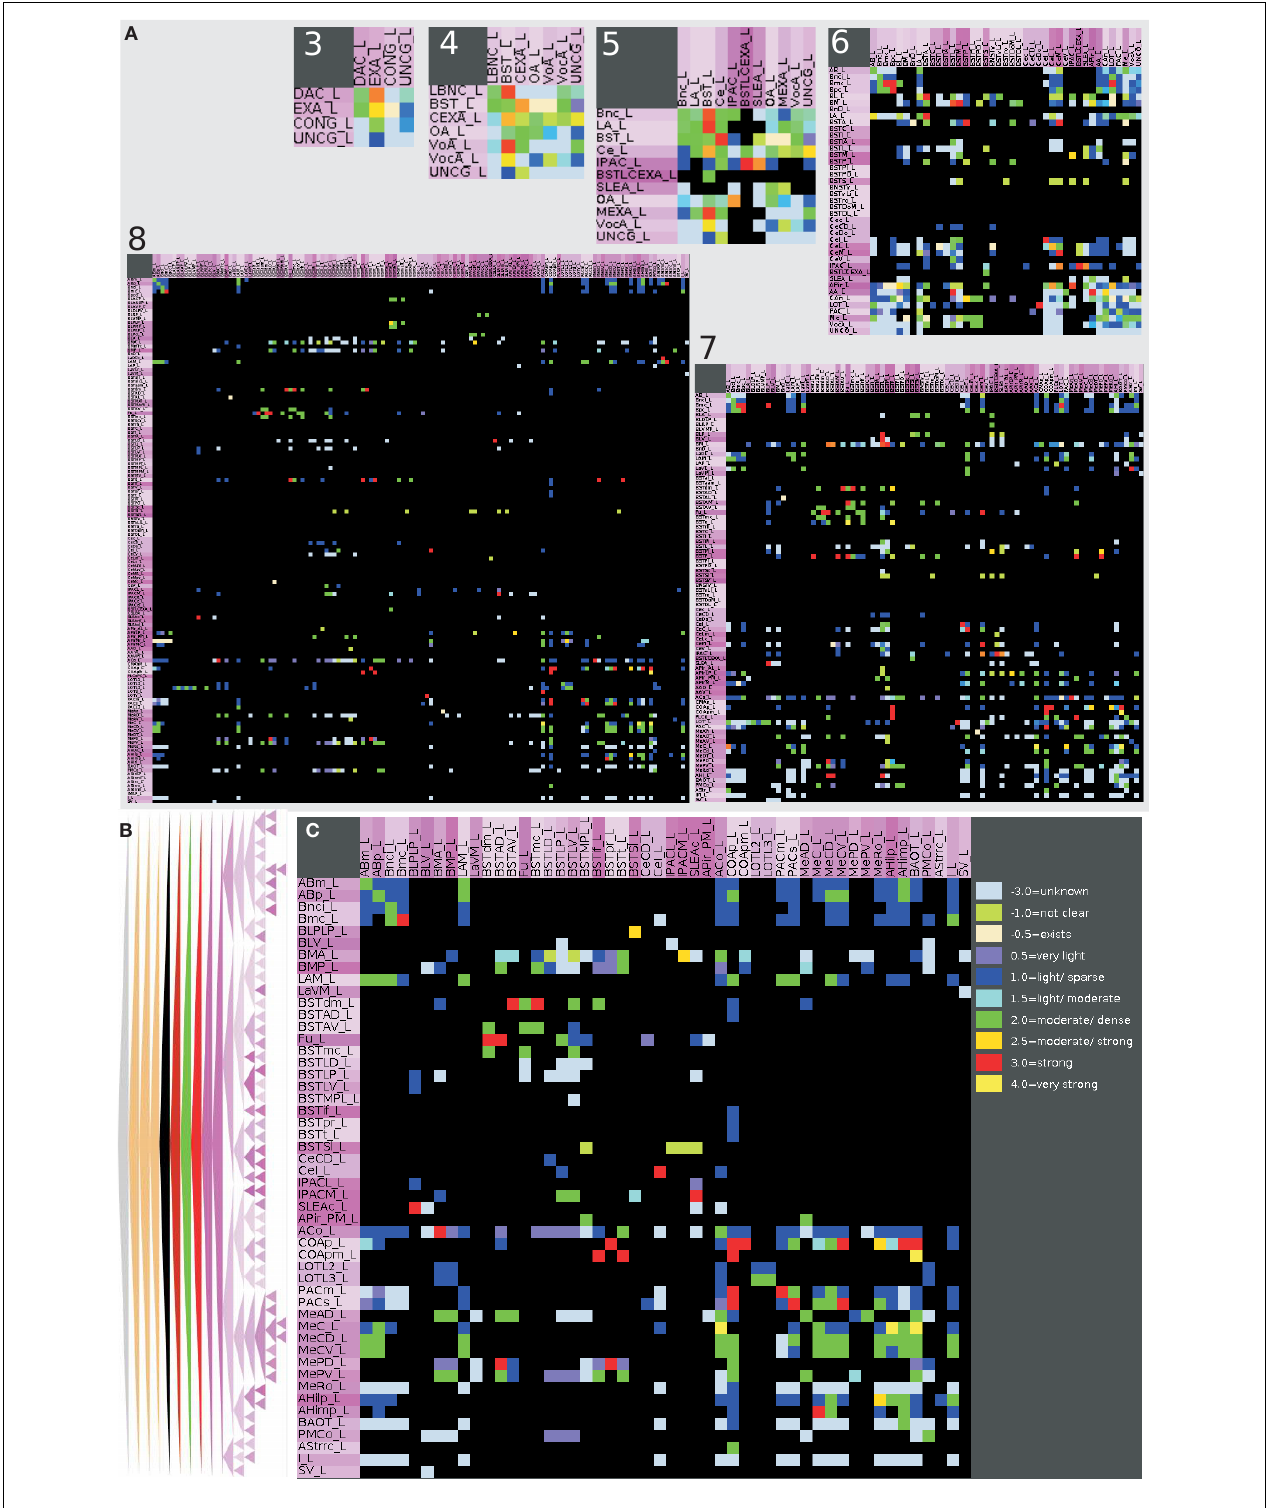
The sequence of regions is predefined by the sequence of leafs of the defined region hierarchy (see Materials and Methods). (B) Triangle representation of all regions that have at least one input and one output at level 8 and (C) the corresponding adjacency matrix describing 49 regions and 464